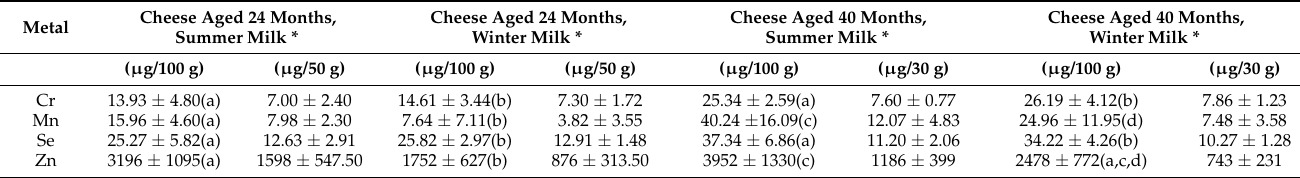
Table 2. Concentration of trace elements in Parmigiano Reggiano cheese at different months of ripening, expressed per 100 g and per consuming portion (30 g and 50